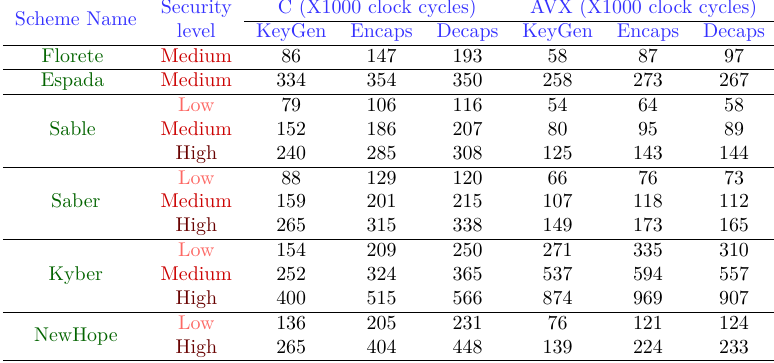
Table 3: Performance comparison in portable C and AVX2 implementation of Scabbard with other lattice-based KEMs.